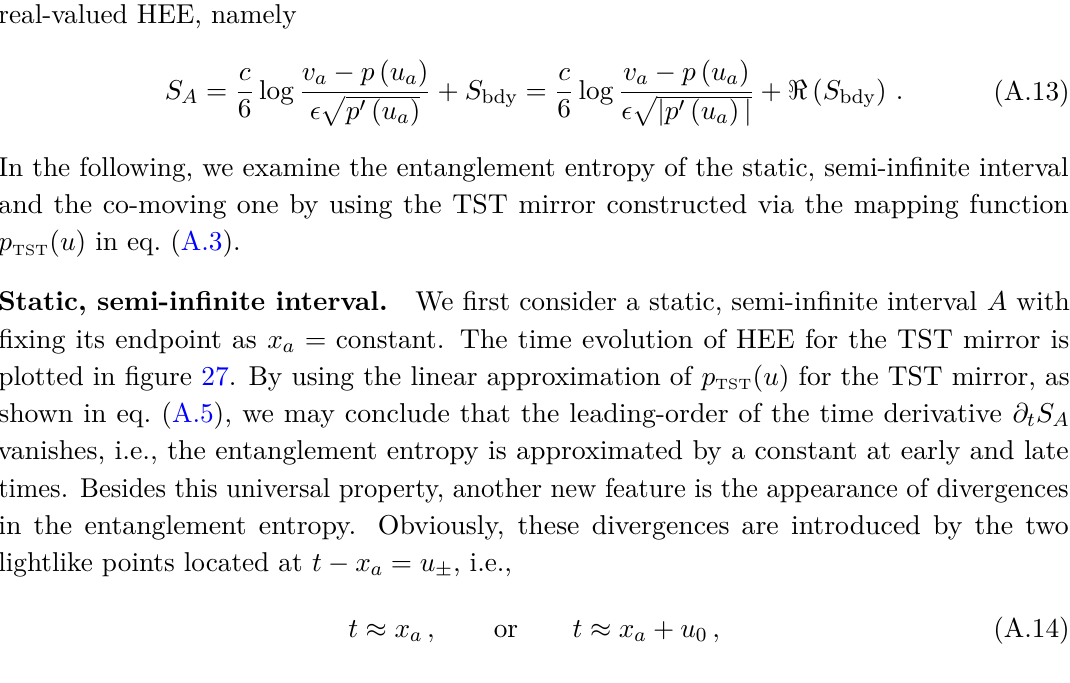
Figure 27 . Time evolution of HEE S A of a subsystem A in the presence of a TST mirror. Left: static, semi-infinite interval with endpoint located at x interval at various distances to the TST mirror. Note that all peaks appearing in both plots are infinite in